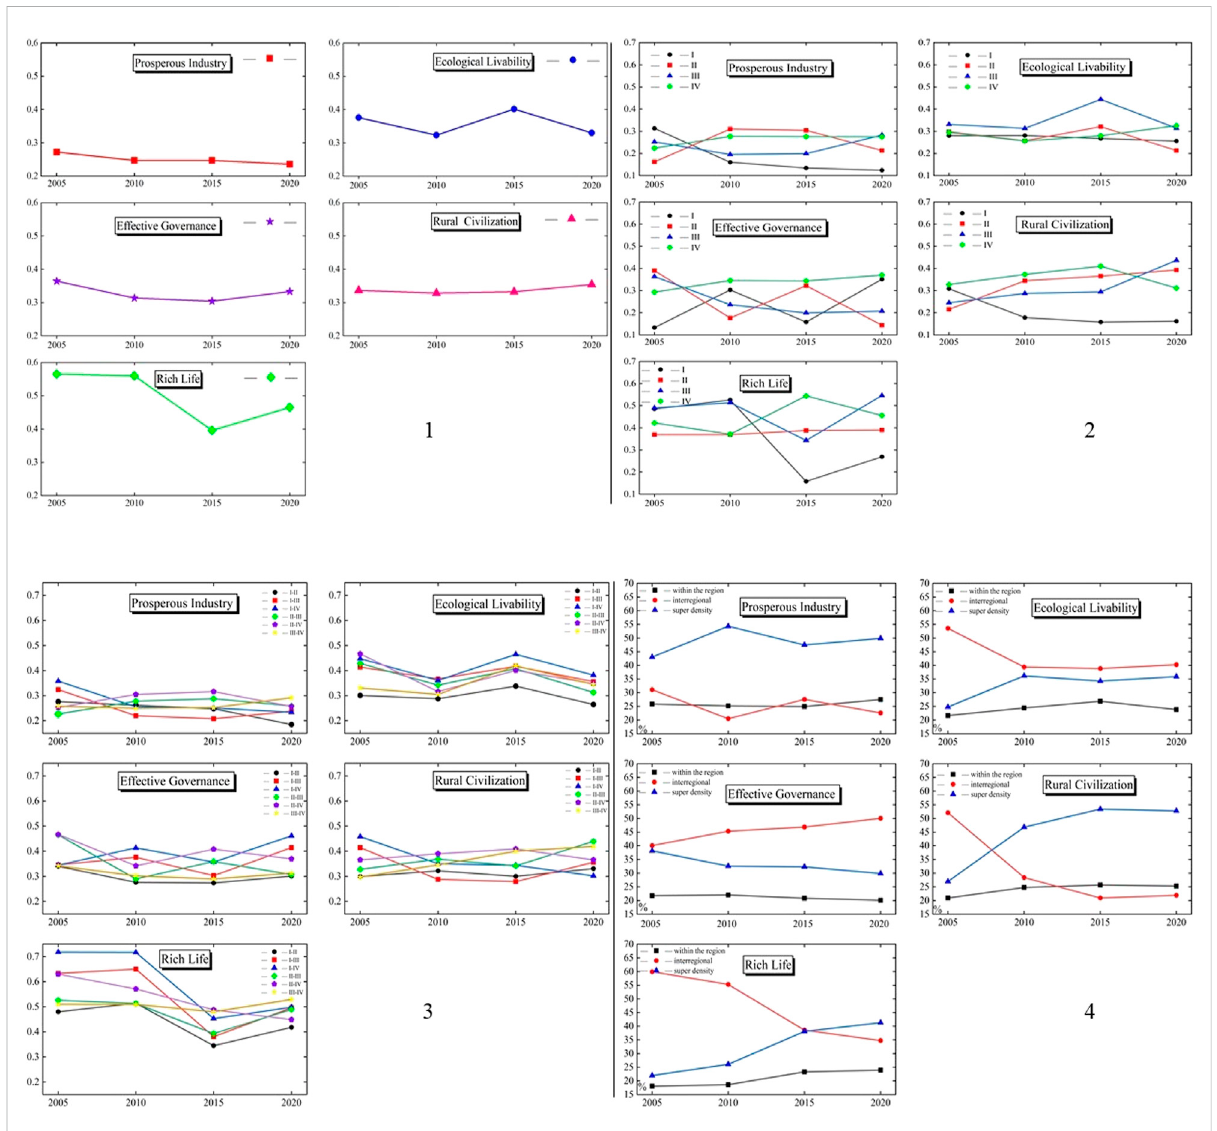
FIGURE 3 The evolution results of Gini coef fi cient of each type from 2005 to